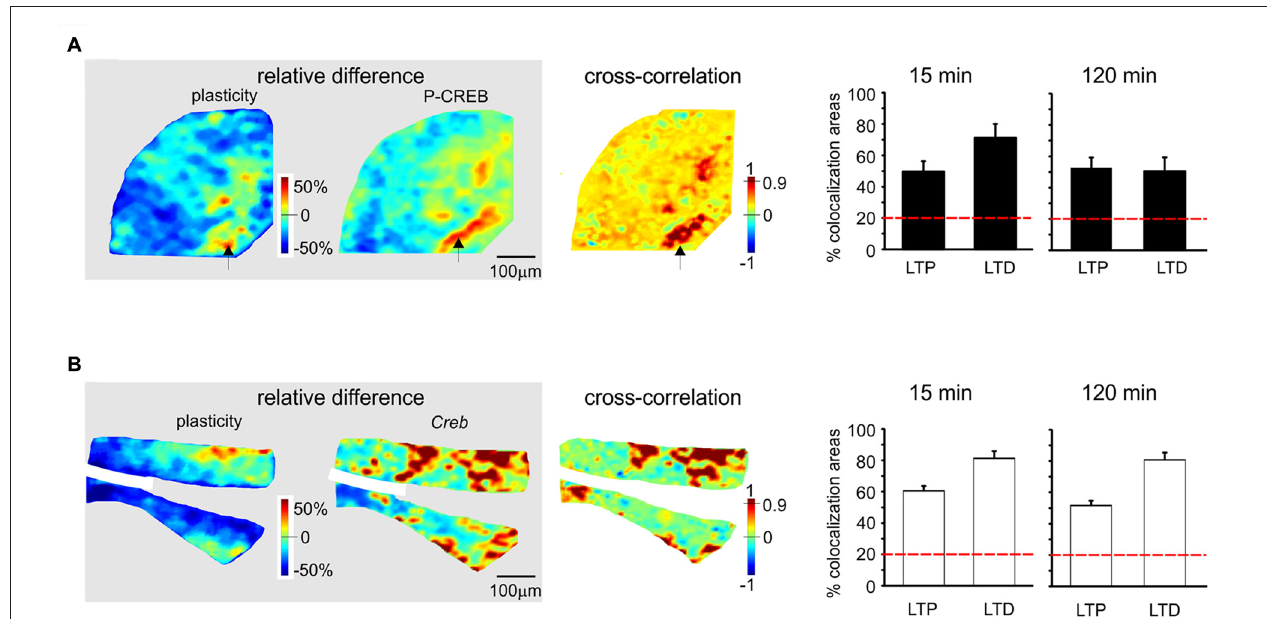
FIGURE 5 | Spatial colocalization of LTP and LTD with the levels of activation of the CREB system following TBS. The maps on the left show the spatial distribution of LTP and LTD (i.e relative difference in circuit responsiveness with respect to controls) and protein/mRNA expression levels (as a relative difference with respect to the average expression level; Equation 1). The map on the right shows the cross-correlation between corresponding pixels in the other two maps (Equation 2). All the maps refer to measurements taken 120 min after TBS. The histograms show the percentage area showing colocalization of LTP and LTD with the relative levels of protein/mRNA at both 15 min and 120 min following TBS. The correlation is positive when LTP is associated with expression levels above average (both values are > 0) and when LTD is associated with expression level below average (both values are < 0). Only correlations with C > 0.9 have been used to construct the histograms (the values are normalized by the area making LTP or LTD). The dashed red lines represent the level of correlation between random matrices (i.e., the level at which correlation is due to noise). (A) P-CREB protein. The area showing colocalization of plasticity with P-CREB in these maps is 46.2% for LTP and 48.8% for LTD. (B) Creb mRNA. The area showing colocalization of plasticity with Creb in these maps is 43.1% for LTP and 66.6% for